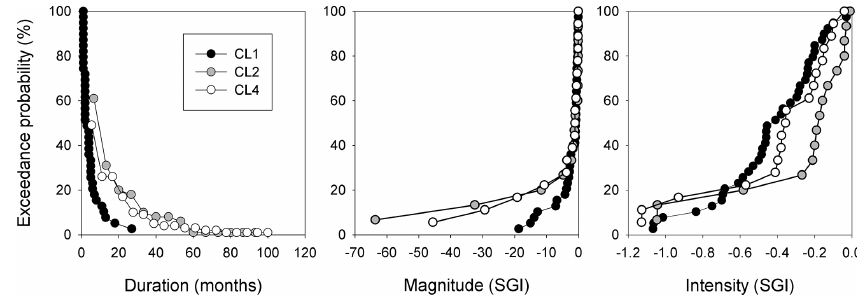
Figure 11. Empirical distribution of (a) drought duration, (b) drought magnitude, and (c) drought intensity for clusters CL1, CL2 and